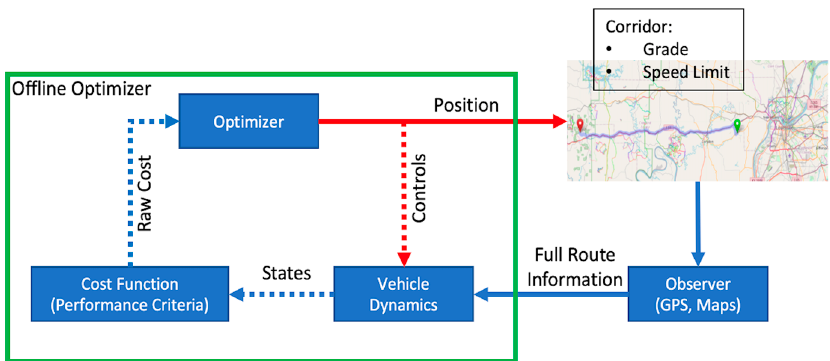
Figure 3. Overview of the problem architecture. Dynamic Program